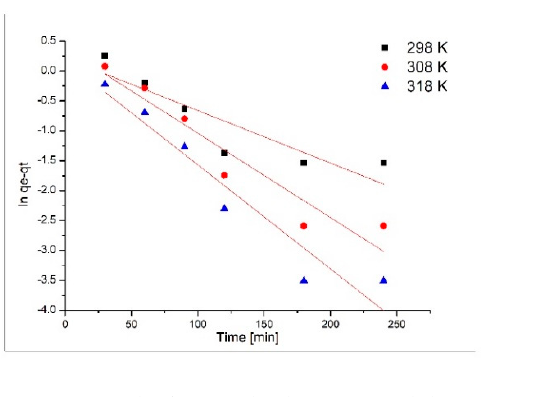
Figure 6. Kinetic studies.